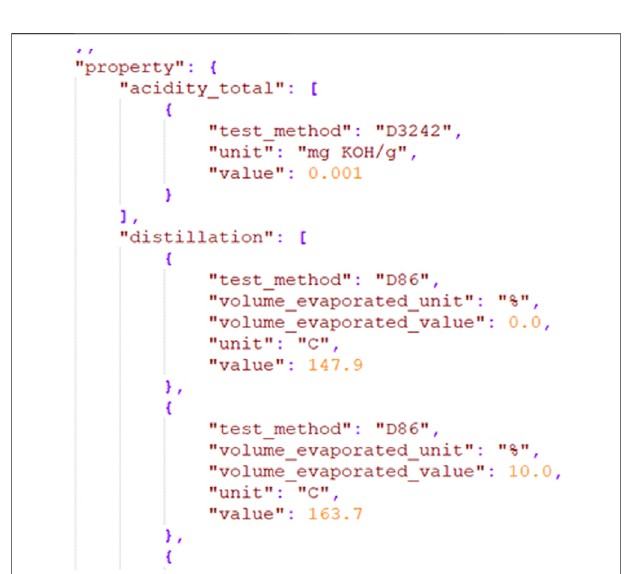
FIGURE 3 | Excerpt of the standardised fuel property schema showing the formatted structure of the data recorded including fuel meta data.